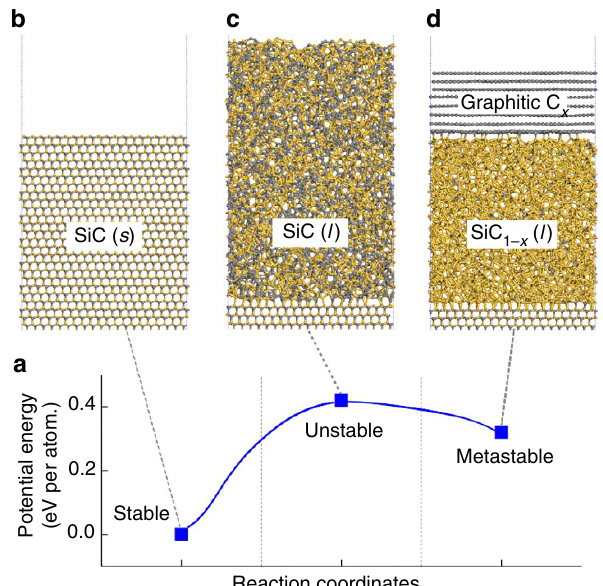
Fig. 1b disappears. A high-magnification image (Supplementary Fig. 7b) of an island structure, stacked on the 3C-SiC surface,